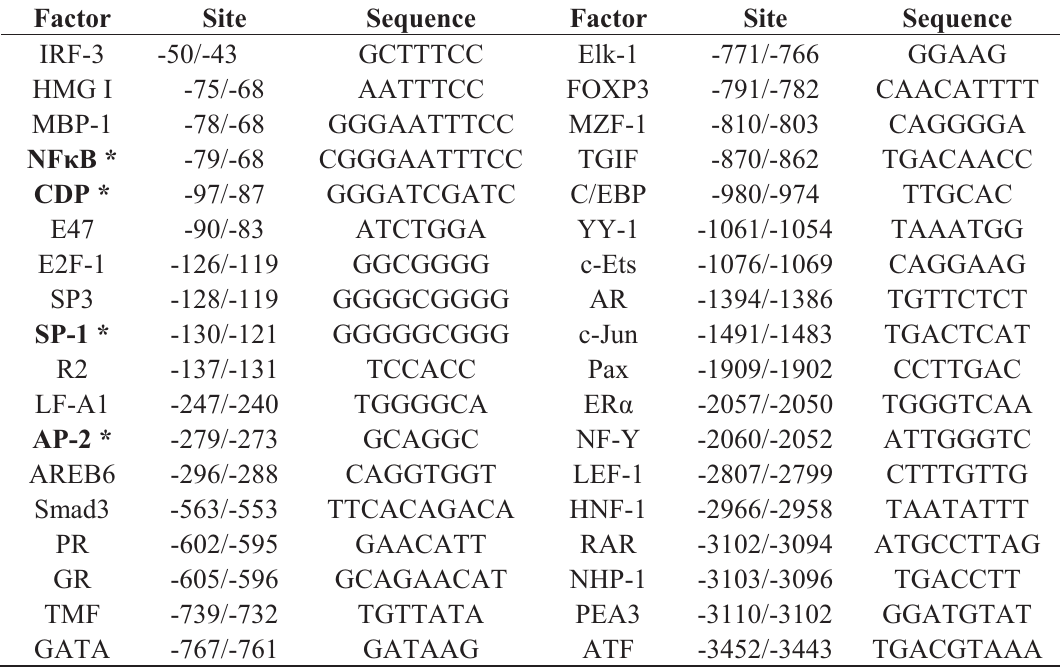
Table 3. List of putative transcription factor binding sites in human CXCL1 promoter.